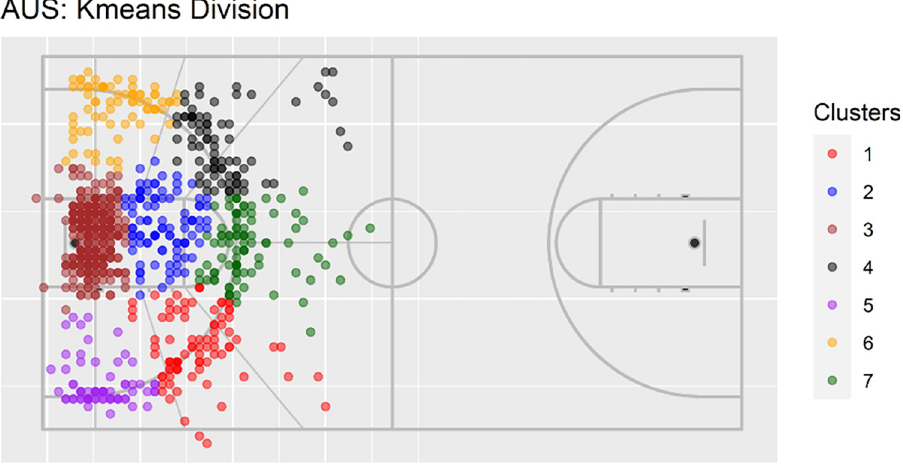
Fig 2. Kmeans for Australia